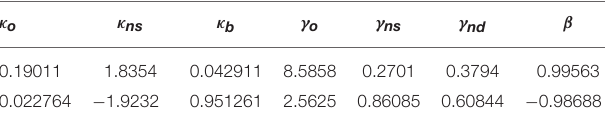
R 0.1112, ( v c , g c + ). = ∈